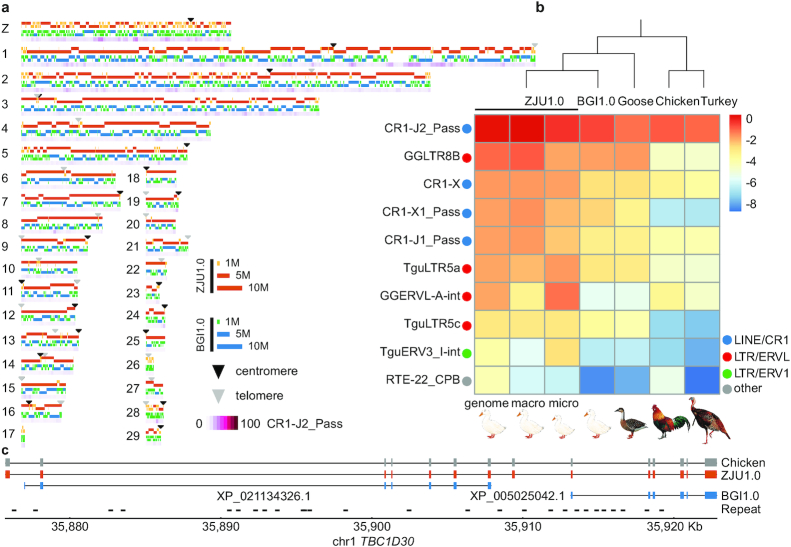
Comparing the new duck genome to other avian genomes. a, Schematic plot of each chromosome, showing the mapped contigs of ZJU1.0 (orange/yellow) and BGI1.0 (blue/green), putative centromeres (black triangles), and telomeres or interstitial telomeric sequences (grey triangles), and the most abundant repeat CR1-J2_Pass present in the gap regions of BGI1.0 (purple gradient). b, Comparisons of the top 10 most abundant repeats in the duck genome (ZJU1.0 whole genome, macrochromosomes, microchromosomes, and BGI1.0 assembly) to other Galloanseriformes bird genomes (goose, chicken, turkey). The more red, the higher the proportion of assembled repeat content. c, An example gene annotation improvement showing that 2 genes in the BGI1.0 genome are really 1 gene in the ZJU1.0 genome and were fragmented into 2 because of low resolution of repeat sequences disrupting the previous genome assembly of exons.